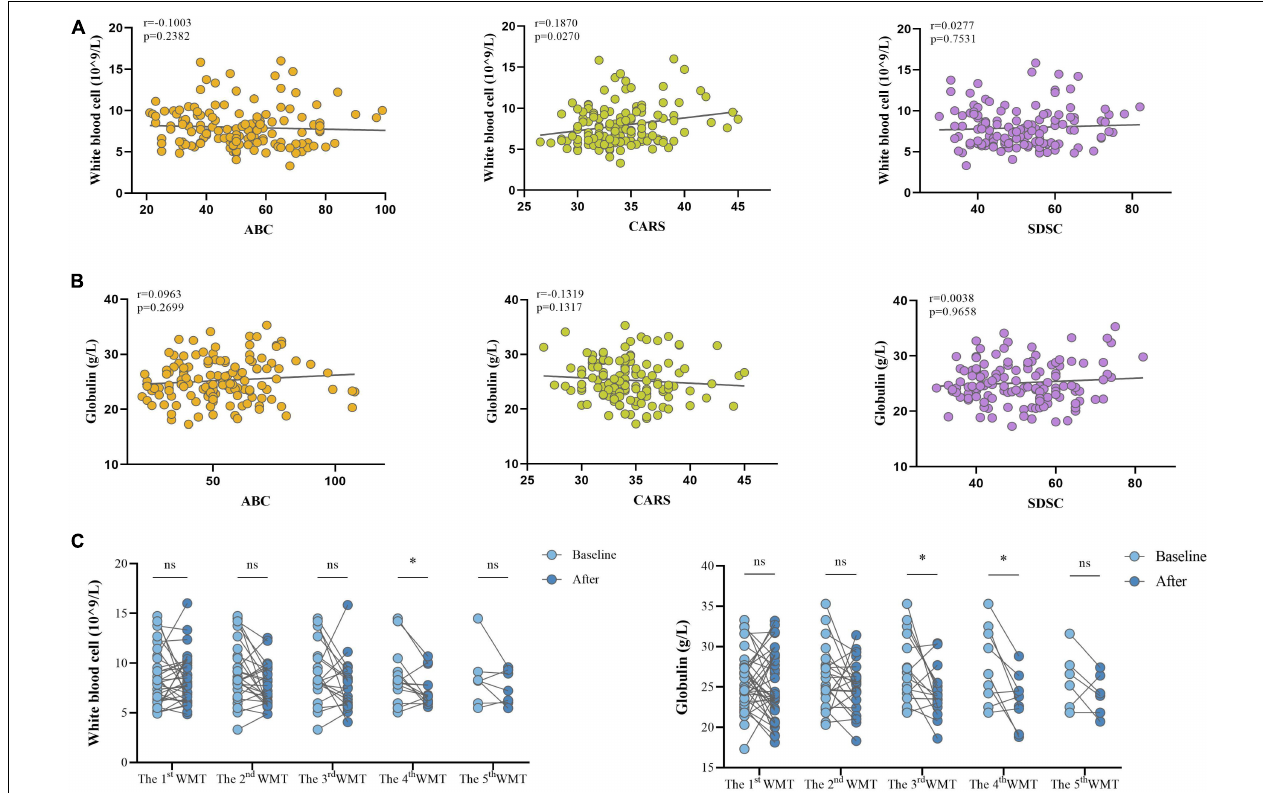
FIGURE 4 | Effect of WMT on WBC and globulin levels in children with ASD. (A) Spearman correlations between WBC counts and clinical scores (ABC, CARS, and SDSC). (B) Spearman correlations between globulin levels and clinical scores (ABC, CARS, and SDSC). (C) WBC and globulin levels before and after WMT. Paired data are from each course compared with their primary baseline. ABC, Aberrant Behavior Checklist; CARS, Childhood Autism Rating Scale; SDSC, Sleep Disturbance Scale for Children; WBC, white blood cell; WMT, washed microbiota transplantation. Spearman correlation and Wilcoxon signed-rank tests were used to determine statistical significance. ∗ P < 0.05, ns P > 0.05 not